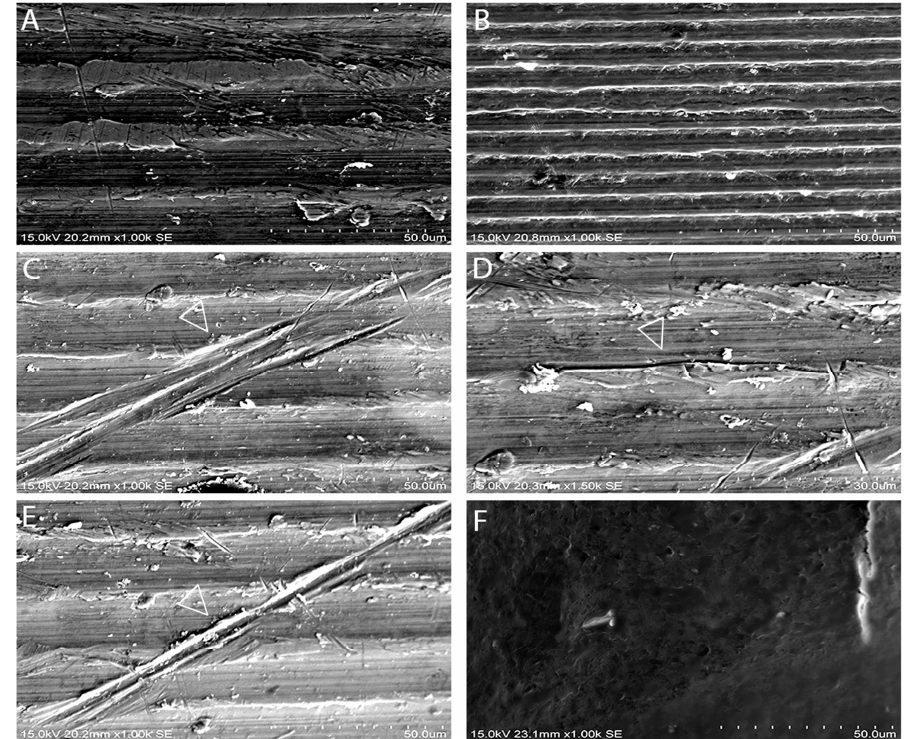
Figure 1. Surface analysis of retrieved dental implants. ( A ) Titanium Straumann (ST), Waldenburg, Switzerland implant control group (new); ( B ) TiUnite ® (TiUn), Goteborg, Sweden; ( C , D ) SEM micrographs of surface defects in TiUn retrieved implants (white arrow). The defects were quite abundant and consisted essentially of superficial craters; ( E ) SEM micrographs of surface defects defined as “crack ‐ like” in TiUn (white arrow). These cracks appeared deeper as characteristic of full cracks and slightly wider; ( F ) SE analyses of the apical portion of titanium Straumann. Table 1. Observed defects on the implant surfaces.